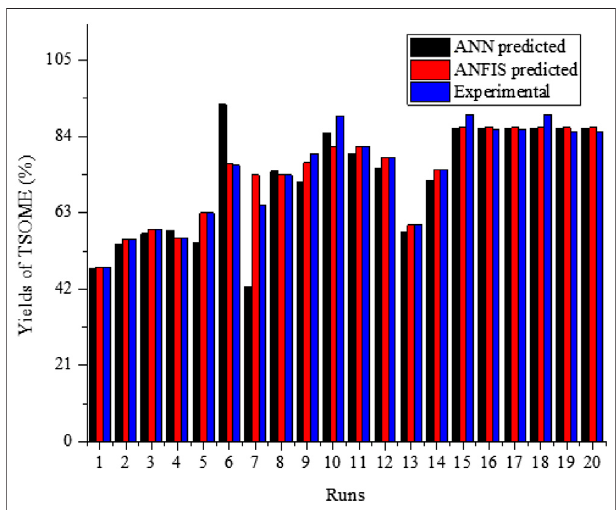
FIGURE 12 | Runs vs. Experimental, ANN, and ANFIS predicted yields.